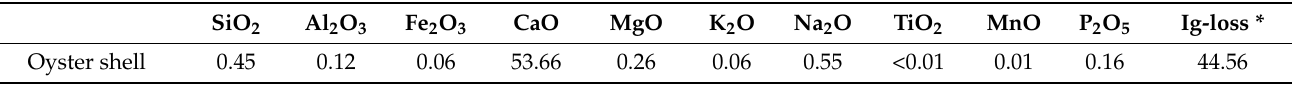
Figure 4. Fineness modulus of oyster shell aggregate with classified. Table 1. XRF analysis of oyster shell (%).